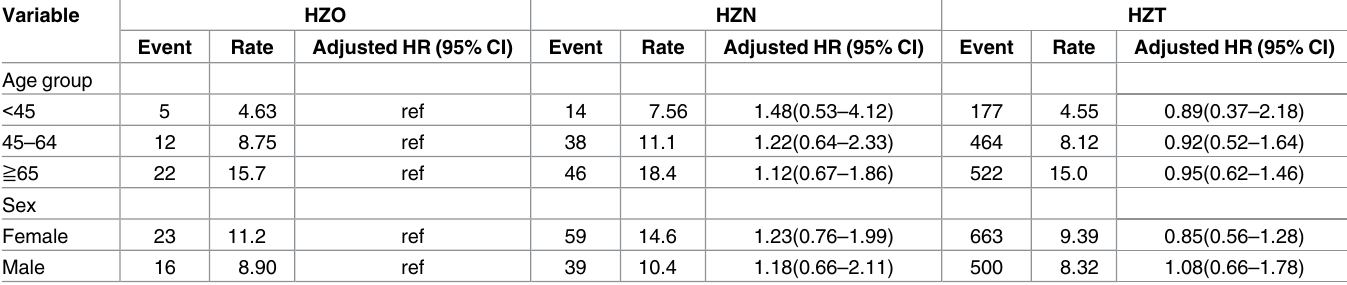
Table 6. Risk of herpes zoster complications (primary trigeminal neuralgia) in different types of herpes zoster stratified by age and sex. Adjusted HR: Adjusted for age, sex, CAD, hypertension, hyperlipidemia, DM, stroke, AF, renal disease, heart failure, cancer, chronic hepatitis, and SLE. Rate: inci- dence rate per 1000